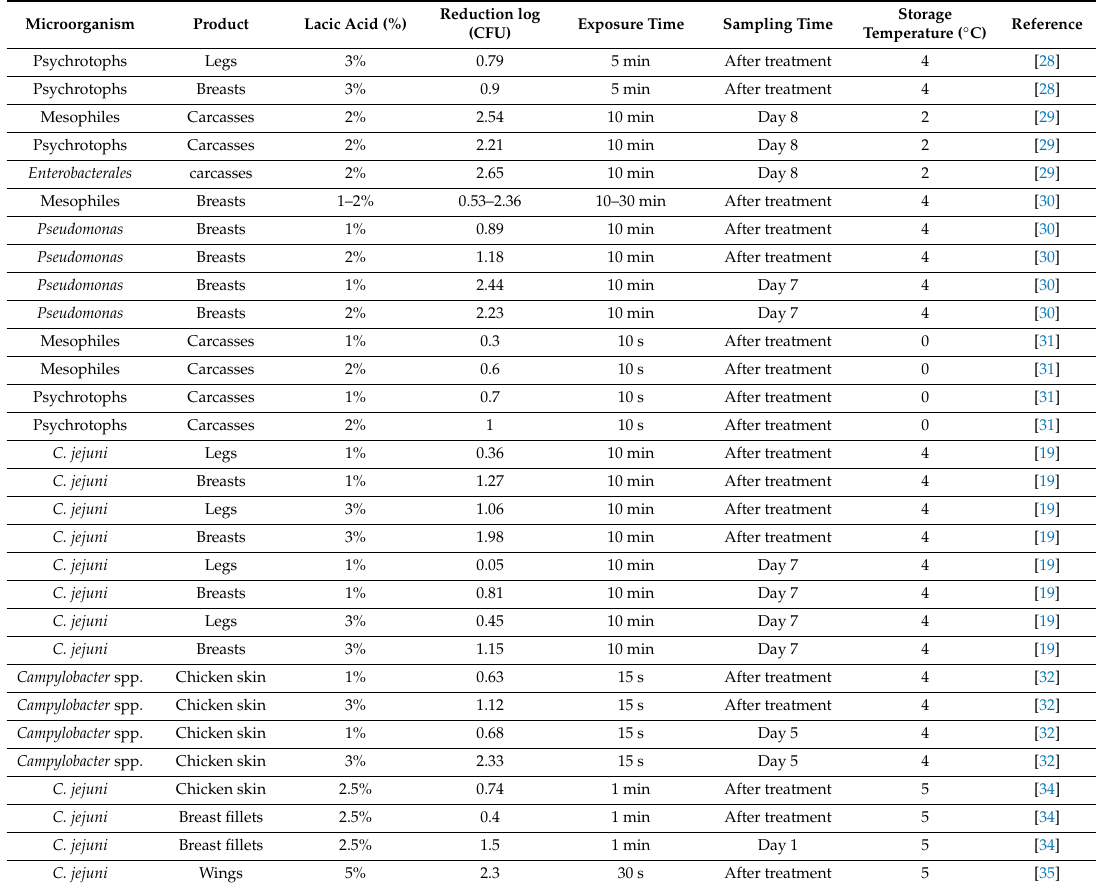
Table 7. E ffi cacy of lactic acid treatment on the decontamination of